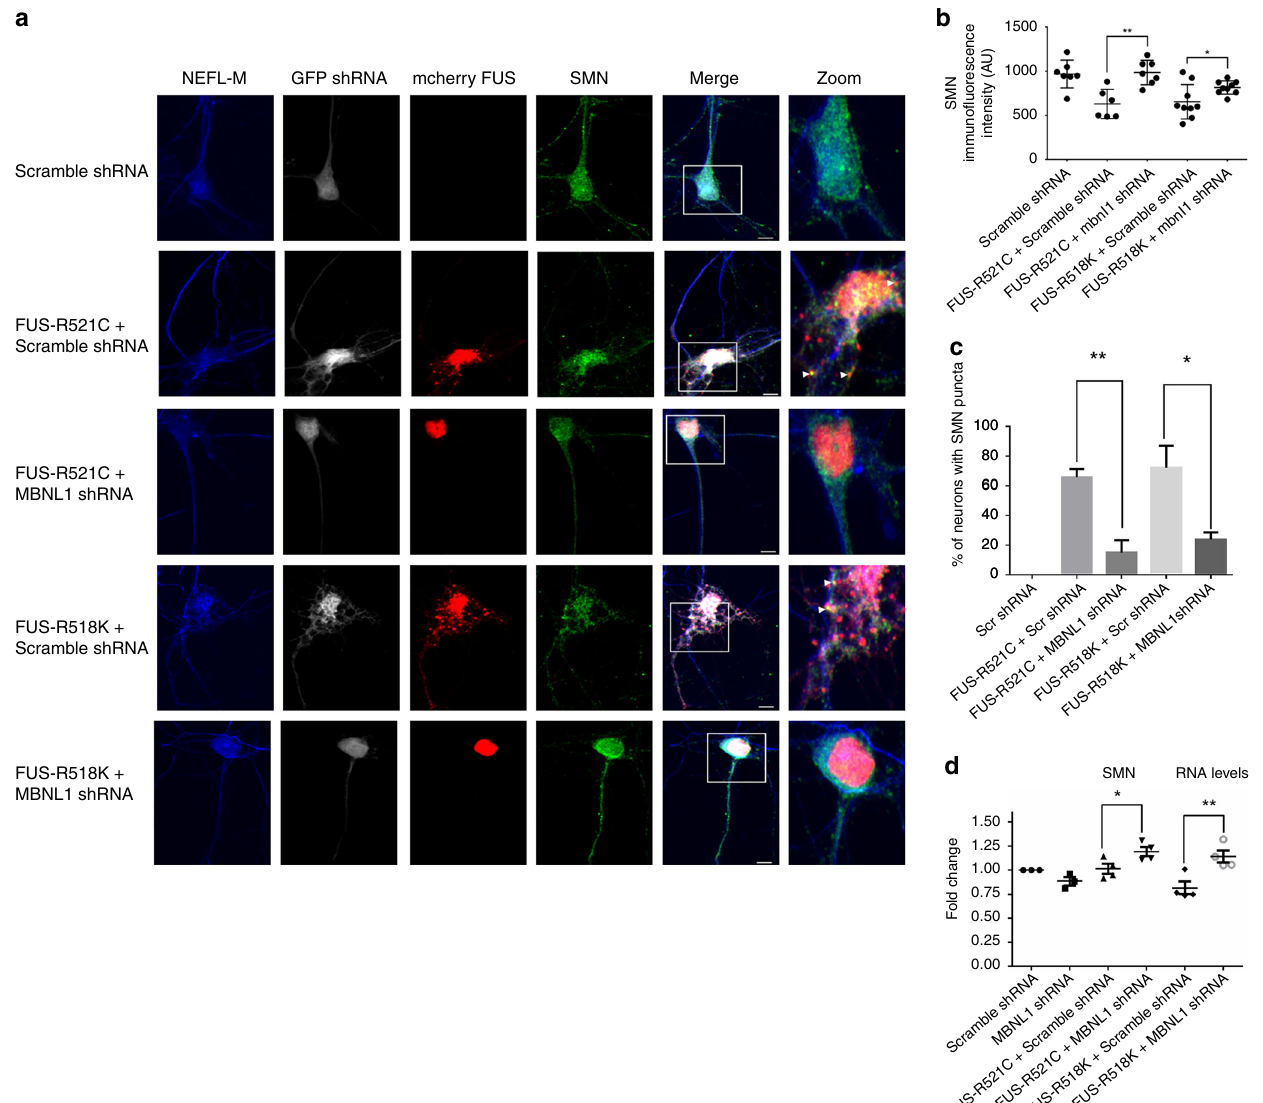
Fig. 6 MBNL1 KD prevents mislocalization of axonal SMN protein. Cortical neurons were co-transfected with mCherry tagged mutant FUS constructs (FUS-R518K or FUS-R521C) and either GFP tagged MBNL1 shRNA or scramble shRNA and stained with anti-SMN and anti-NEFL-M. Effect of MBNL1 knockdown on SMN RNA levels was determined by qPCR analysis of NSC-34 cells expressing mutant FUS. a Representative confocal images showing SMN and FUS distribution in neuronal cells. NEFL staining was used to trace axons. Labels on the left side of the panel detail which groups were transfected with MBNL1 shRNA or scramble shRNA. White arrows indicate co-localization of mutant FUS and SMN puncta. Scale bars = 5 µ m. b Quanti fi cation of fl uorescence intensity of SMN staining along NEFL positive axons con fi rms that depleting endogenous MBNL1 signi fi cantly rescues loss of SMN in mutant FUS neurons. Each graph corresponds to the representative panel above a . A minimum of 6 – 9 neurons were analyzed in biological triplicates for each measurement. Values presented in each graph are means ± SE. Statistical analyses were performed on GraphPad Prism 6 software using two-tailed t tests (** P = 0.0014, * P = 0.0331). c Quanti fi cation of percentage of neurons with cytoplasmic foci containing both FUS and SMN. A minimum of 5 – 10 cells were analyzed from each group from three independent experiments. Percentage of neurons with FUS and SMN-positive cytoplasmic foci is signi fi cantly reduced in mutant FUS neurons (R521C and R518K) co-expressing MBNL1 shRNA compared with cells expressing scramble shRNA two-tailed t tests were used for the comparisons in d (** P = 0.0072, * P = 0.0352). d qPCR analysis from 3 – 4 biological replicates of NSC-34 cells shows knockdown of